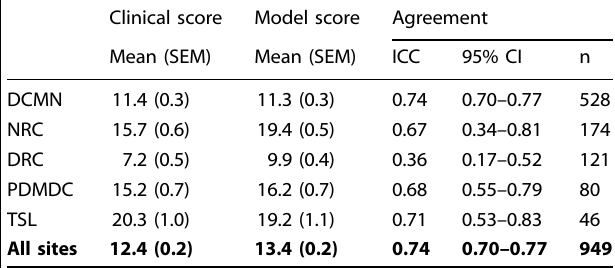
Table 3. Composite bradykinesia score results, broken down by